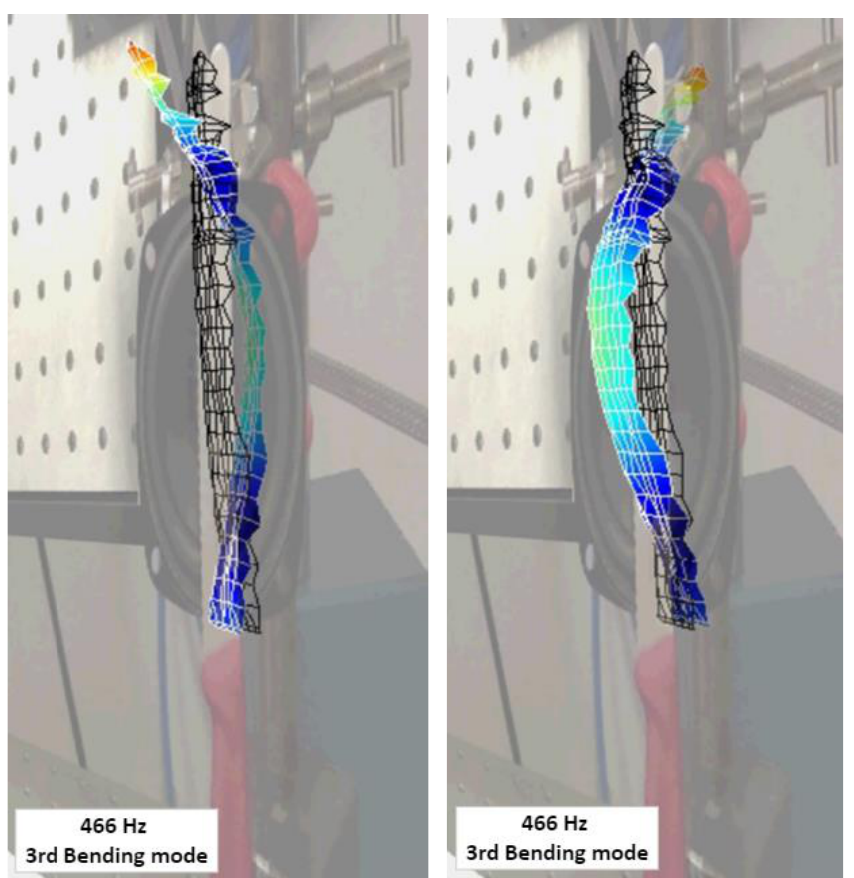
Figure 8. Mode shape for the three first bending modes at 62, 194, and 466 Hz (data visualization from 3D Laser Vibrometer). Table 1. Overall results of the modal analysis in the 0–1.1 kHz